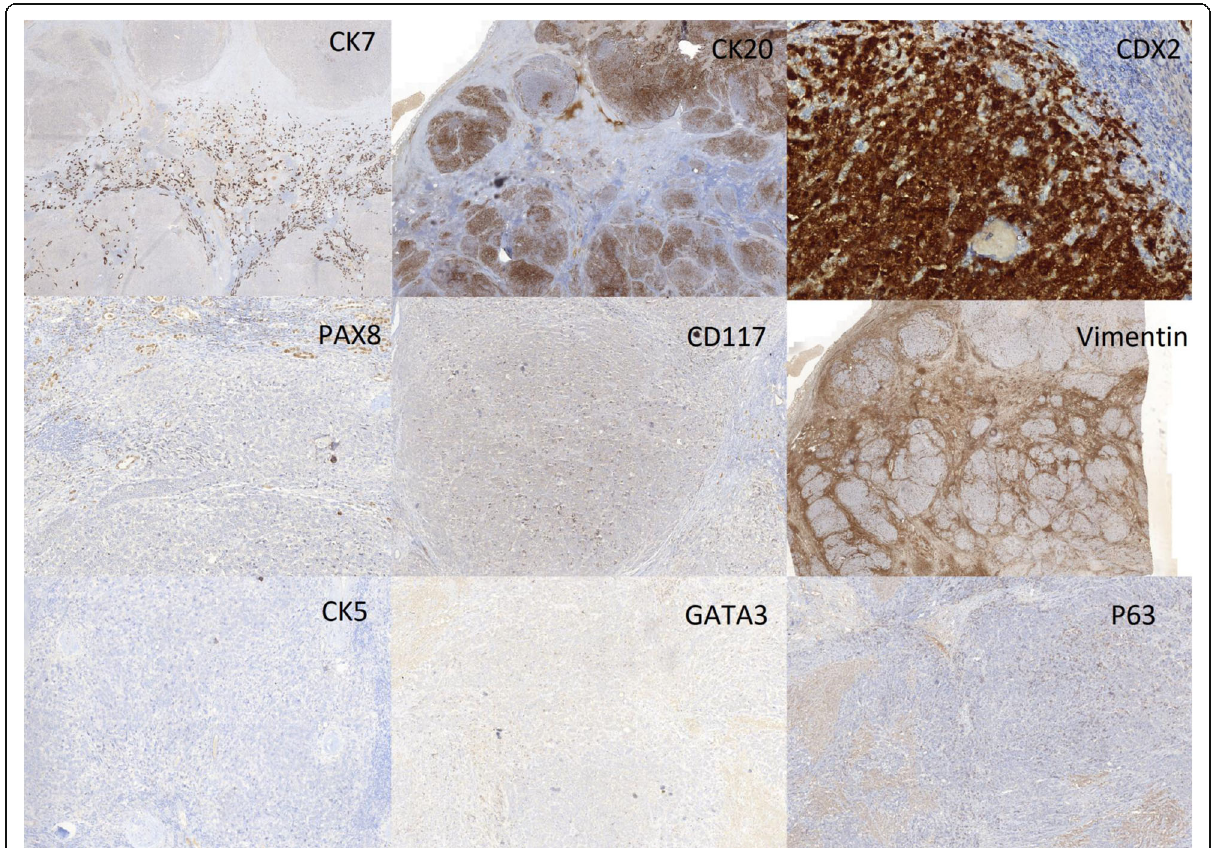
Fig. 4 Immunohistochemical studies performed in the reported case, demonstrating strong positivity for CK20 and CDX2 and negativity for CK7, CK5, p63, GATA3, PAX8, vimentin and